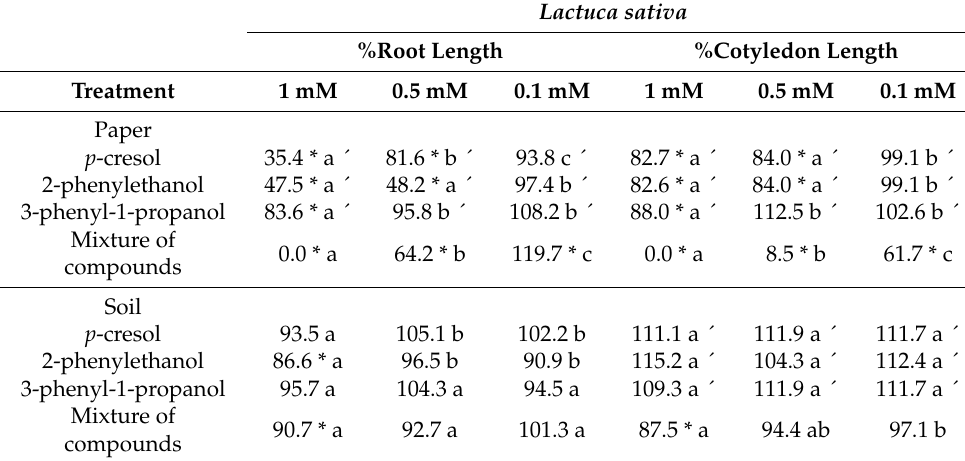
Table 4. Effect of different concentrations of phenolic compounds from the Cistus ladanifer exudate on Lactuca sativa root length and cotyledon, expressed as the percentage relative to the control. Four replicates of each treatment ( n = 4 × 50 = 200 seeds in total for each